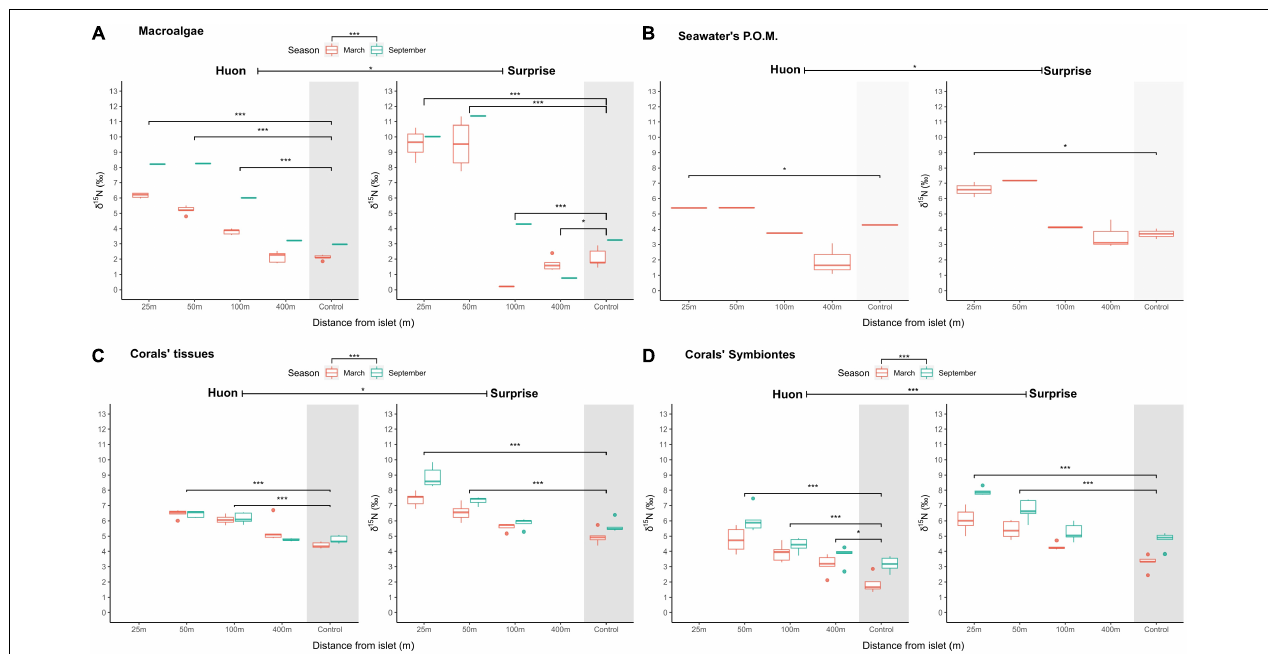
FIGURE 3 | Spatial and temporal variations in δ 15 N values measured in (A) macroalgae, (B) suspended POM, (C) coral tissues and (D) coral symbionts. Asterisks are included: (i) in the legends to mark a significant positive fixed effect of one season compared to the other (higher in Sept.), (ii) next to the site names to mark a positive fixed effect compared to the other site (higher in Surprise), and (iii) between the reference site and the transect positions to mark significant differences in the transect:site effect (higher closer to shore). * Stands for p < 0.05 and *** for p <